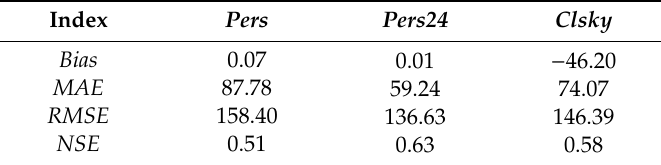
Table 1. Average performances of the Pers , Pers24 , and Clsky predictors on the first 3 hours (whole day).